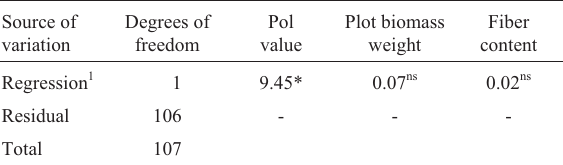
Table 2 - F-test values from the linear regression analysis of the pA37- Eco RV marker as a binary independent variable for the apparent sucrose content by polarization (Pol value; grams of sucrose per kg per 100goffreshcane),plotbiomassweight(tonnageofcaneperhectare)and fiber content (%) of 108 progenies of the SP80-180 x SP80-4966